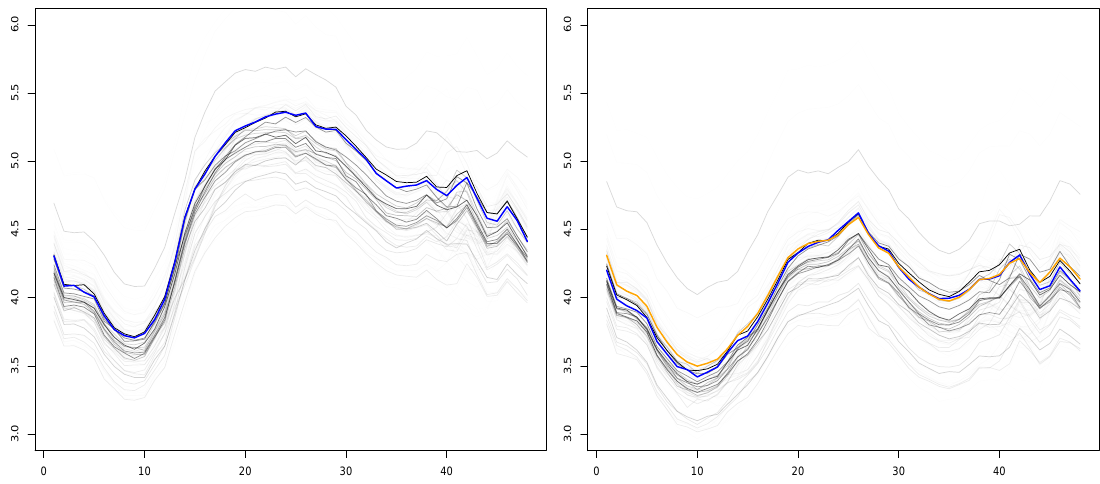
Figure 7. Past and future segments involved in the construction of the prediction by KWF. On each panel, all the days are represented with a transparent colour making visible only the most relevant days for the construction of the